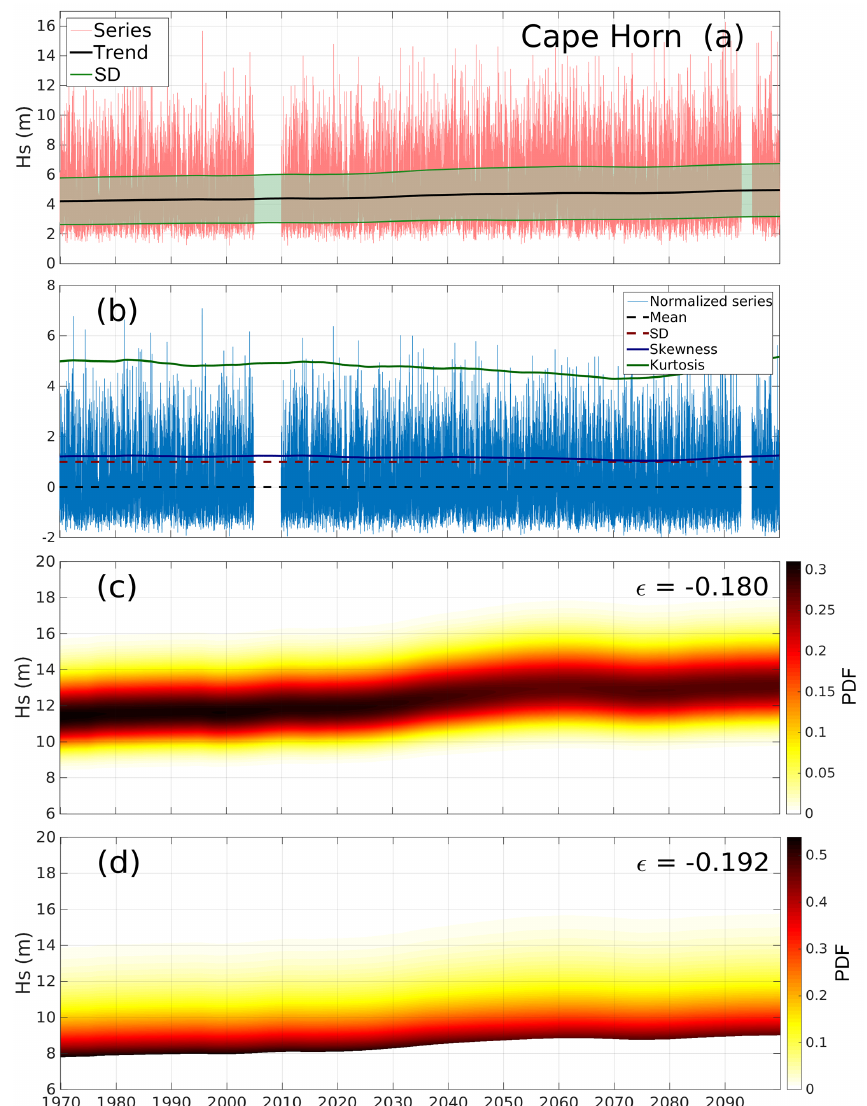
Figure 3. Long-term analysis of the projections of significant wave height in Cape Horn: (a) series, its trend, and standard deviation; (b) the normalized series with higher order statistical indicators; (c) non-stationary GEV of annual maxima; (d) non-stationary GPD of annual peaks. In (c) and (d) the values of the shape parameter ε best fitted for the GEV and GPD distributions are